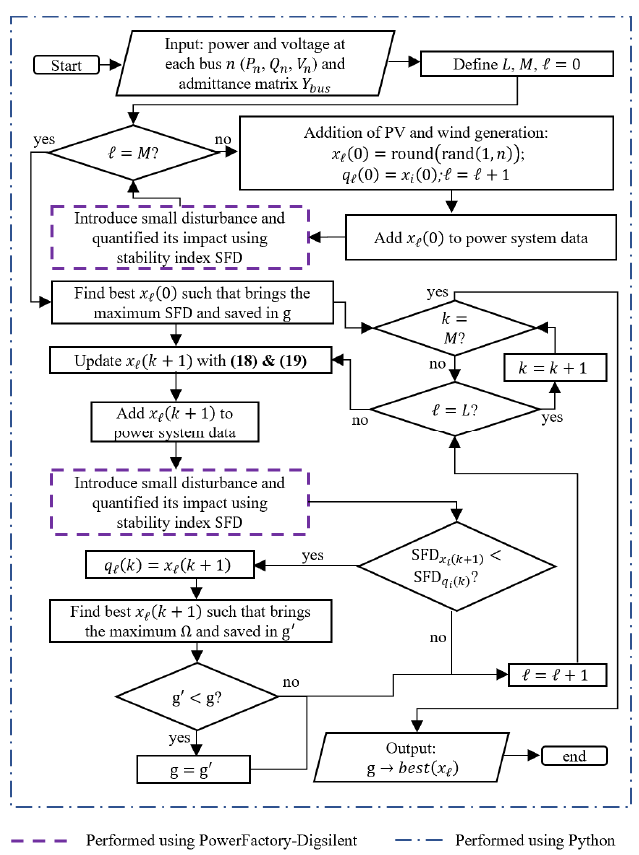
Figure 4. PSO flowchart implemented.